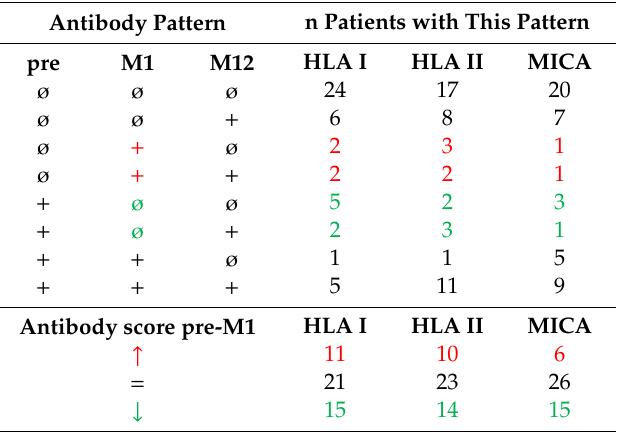
Table 2. Individual courses of HLA / MICA antibodies in 47 kidney transplant recipients pre and at month 1 (M1) and month 12 (M12) after vaccination with Prevenar. Antibody Pattern n Patients with This